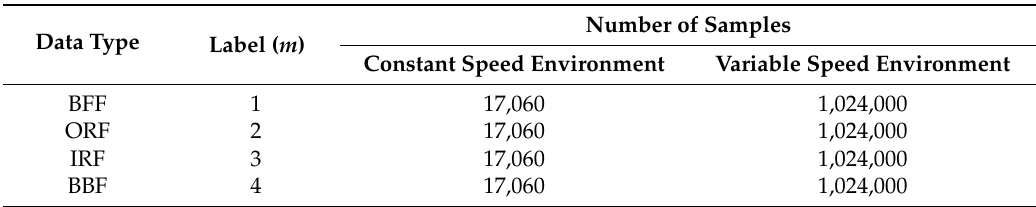
Table 1. Description of the used dataset.